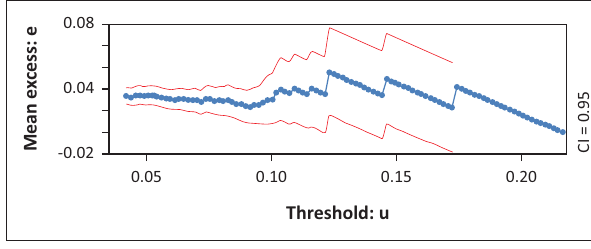
CI, confidence interval FIGURE 3: Mean residual plot for the right tail (negative returns